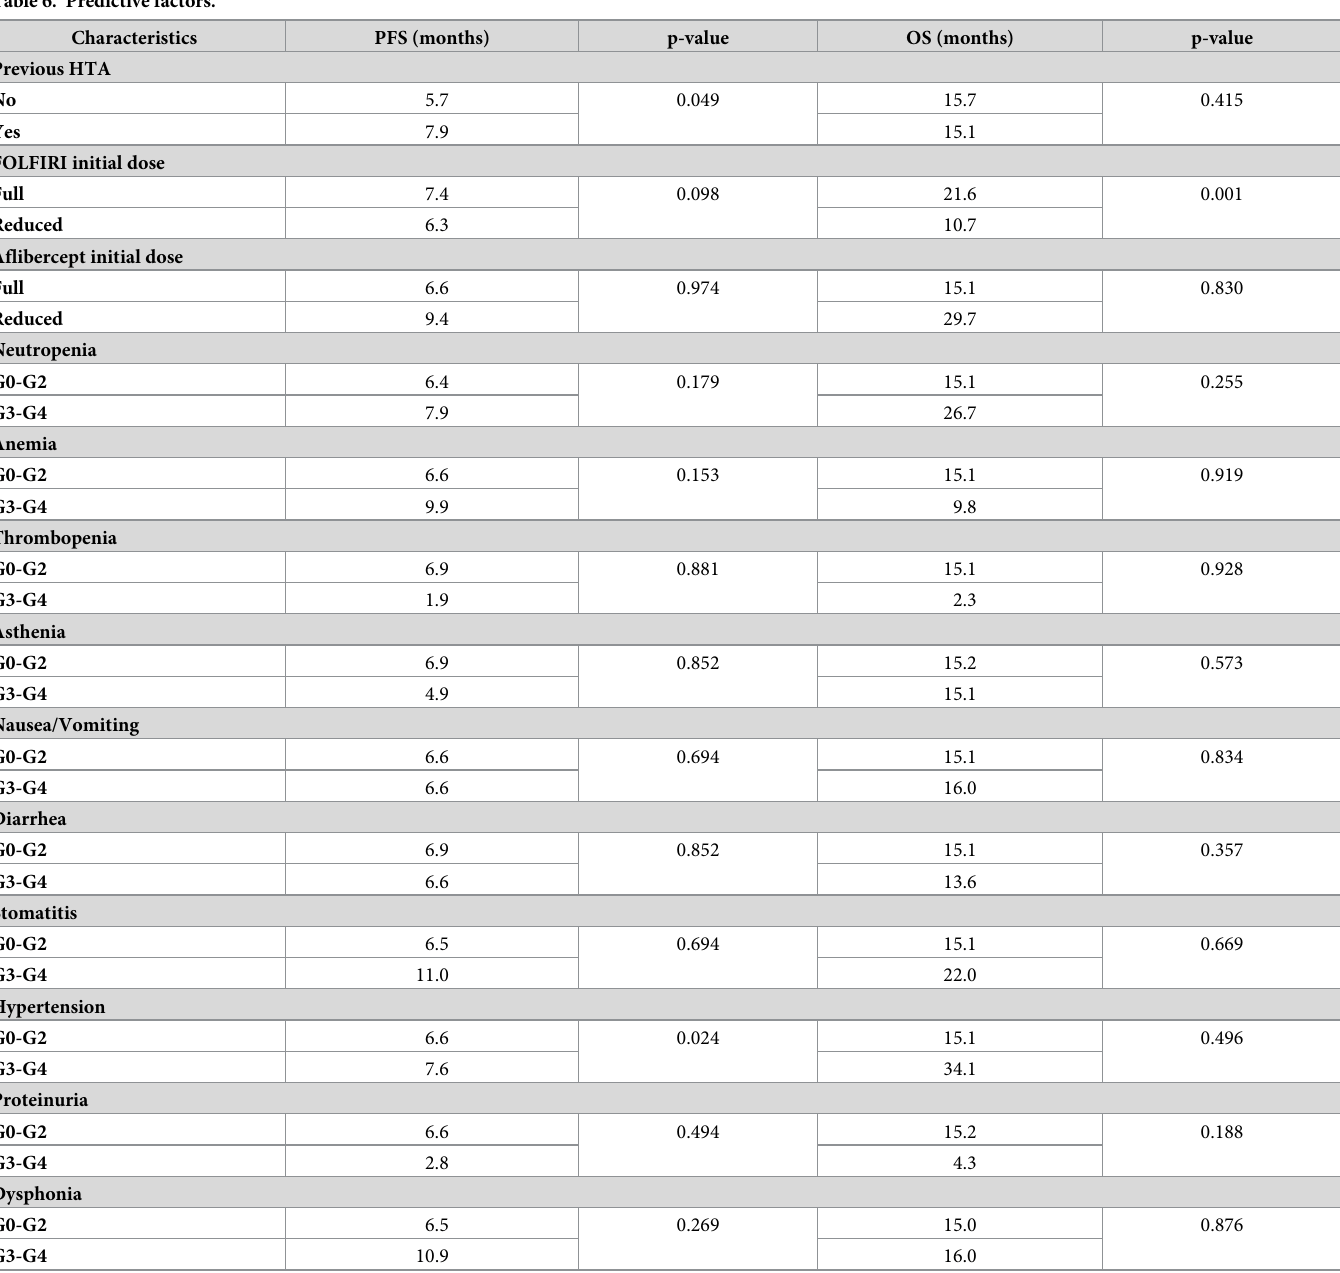
Table 6. Predictive